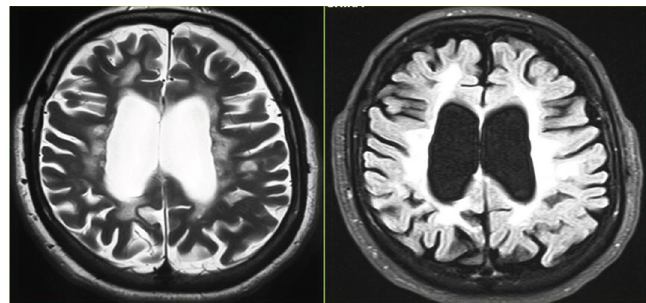
Figure 1: Periventricular T2/ fl air hypersignals associated with subcortical cortical